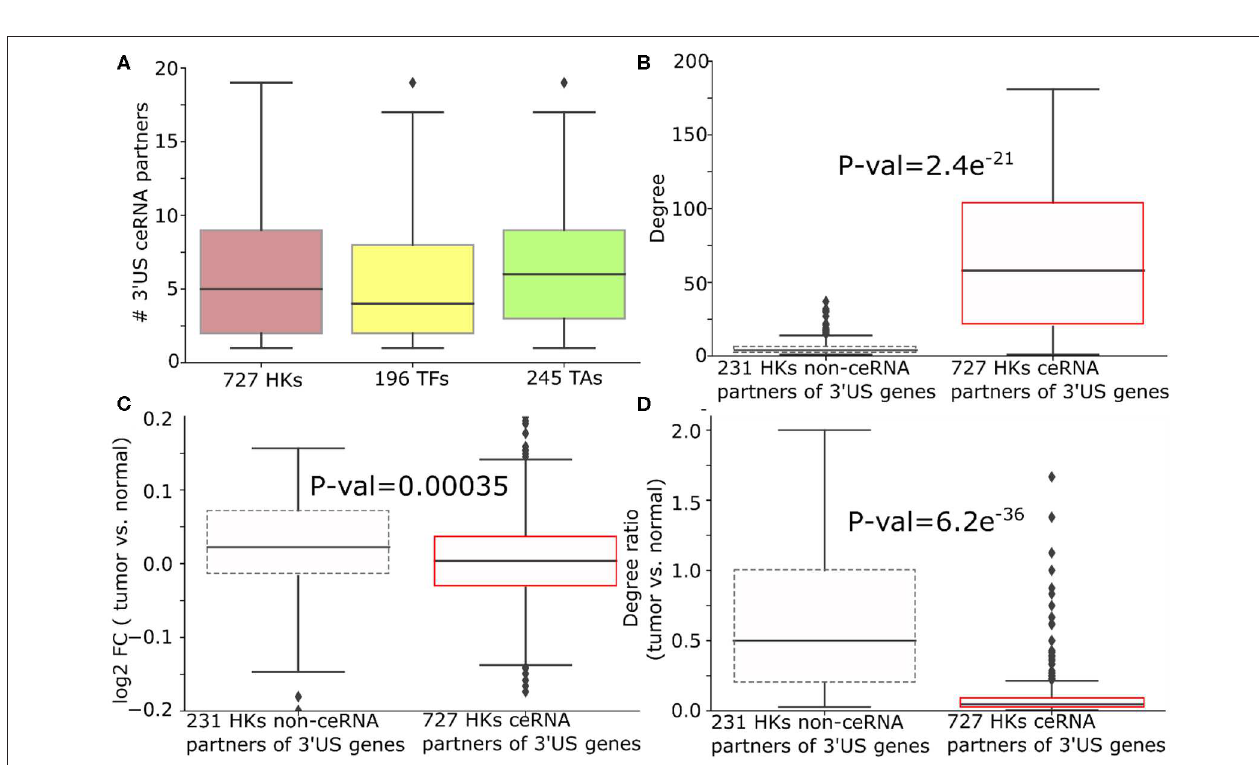
FIGURE 4 | 3 ′ US disrupts ceRNA relationship of HK genes in ER- tumors. (A) Number of 3 ′ US genes connected to housekeeping (HK), transcription factor, and tumor-associated genes in the ER- ceRNA network. (B) Degree (number of neighbors in ER- normal ceRNA network), (C) log 2 fold change (tumor vs. normal), and (D) degree ratio (tumor vs. normal) of 727 and 231 HK genes that are ceRNA partners of 3 ′ US genes or not, respectively. The degree ratio in (D) represents the ratio of the number of neighbors retained in the tumor. various phases (G1/S or G2/M) of various mediators (estrogen or cyclins) are enriched with 144 ER HK ceRNA +